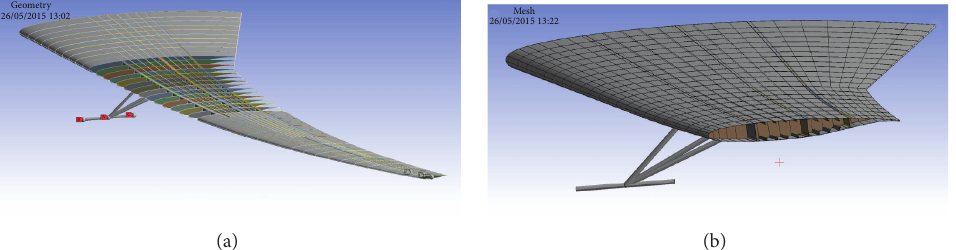
Figure 5: (a) The finite element model of the curved wing (upper and lower skins partially removed). (b) The finite element model of the curved wing (wing structure layout).